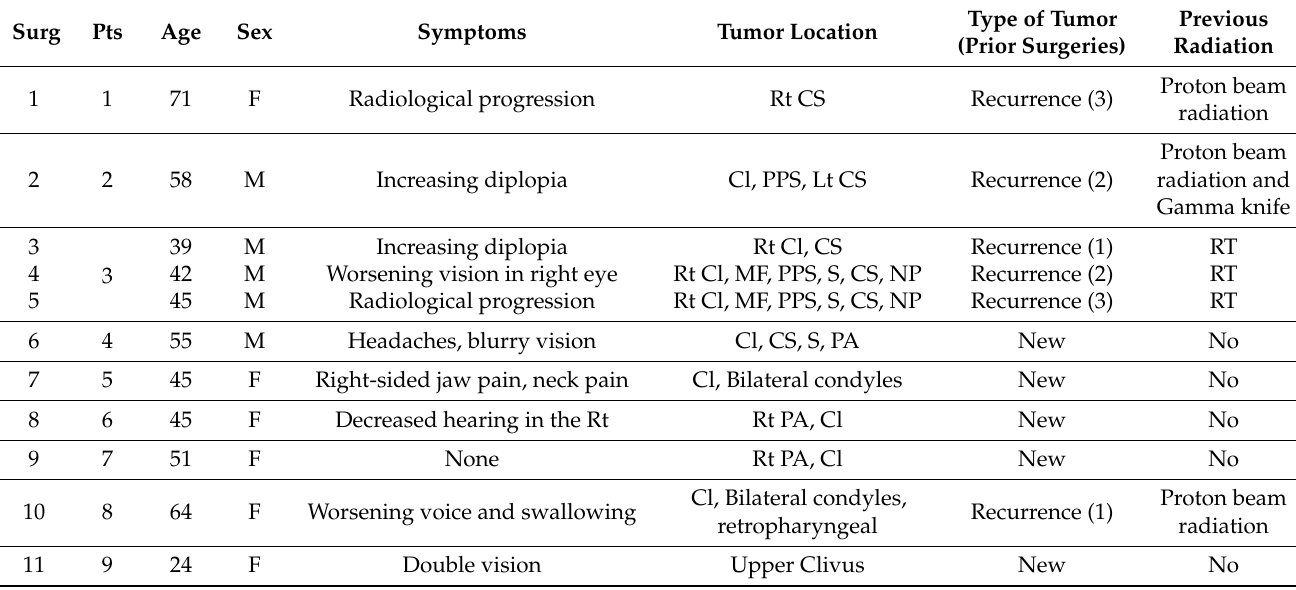
Table 1. Patient